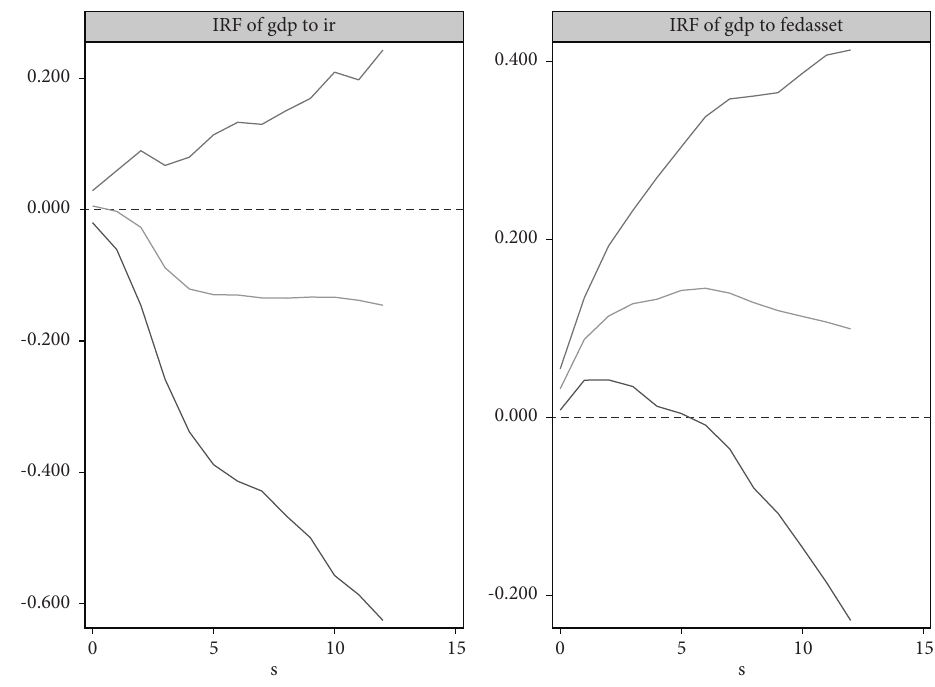
Figure 1: Impulse responses of GDP to U.S. monetary policy shock in BRICS